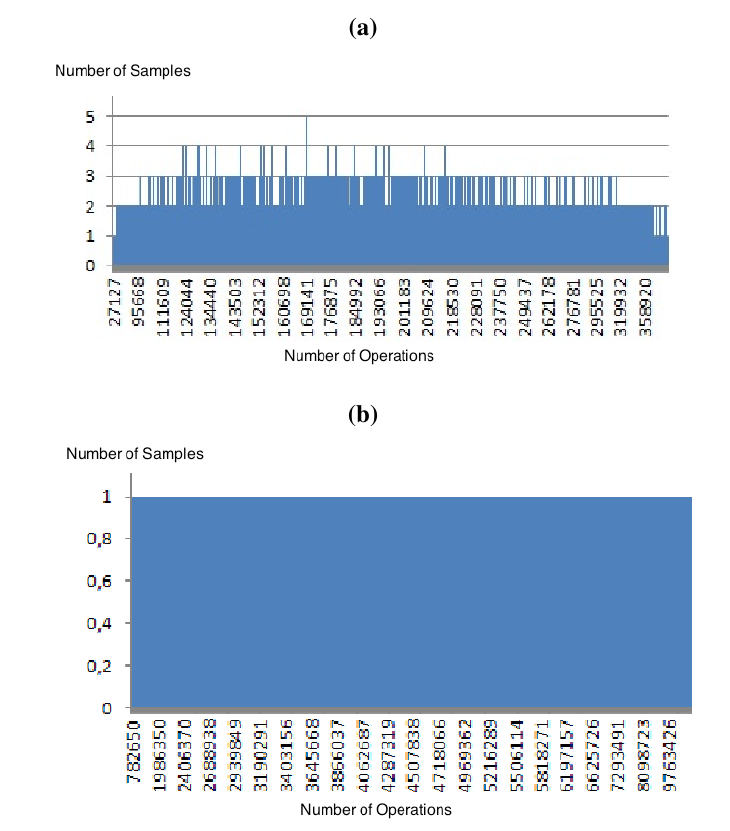
Figure 9. Behaviour unstable near the point of phase shift ( m for n = 200 and m = 1000; ( b ) Distribution found for n = 300 and m = 1500.